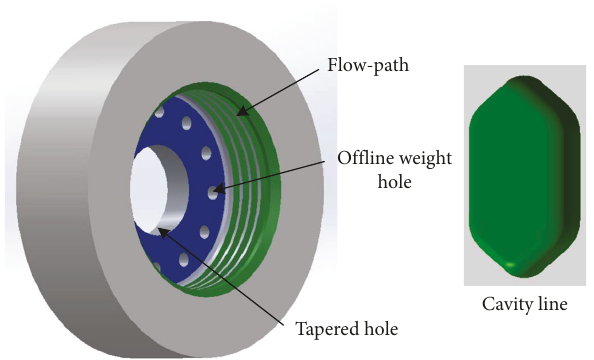
Figure 7: Integrated balance terminal